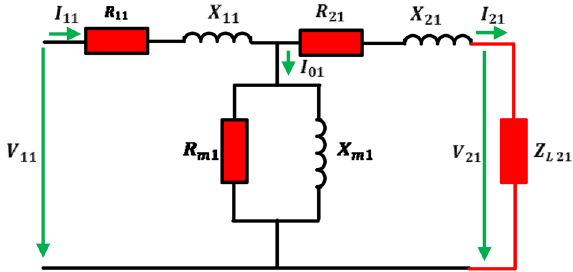
Figure 1. Transformer modelling